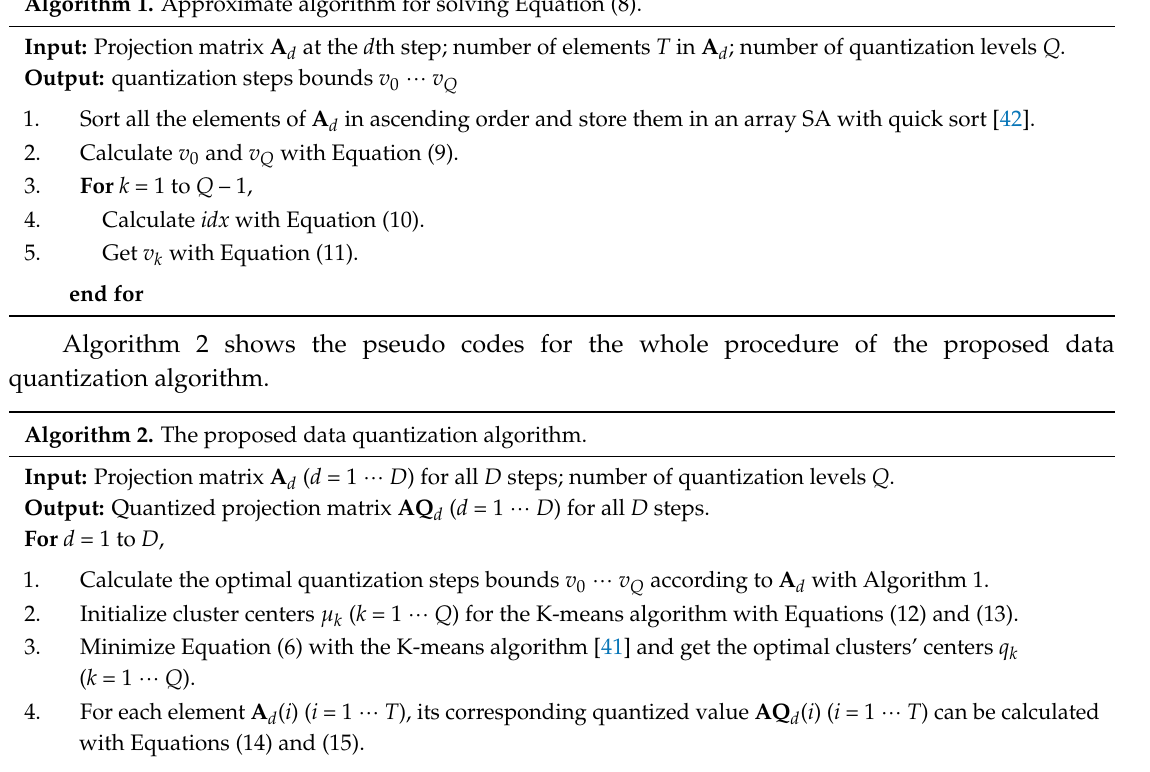
Algorithm 1. Approximate algorithm for solving Equation (8).